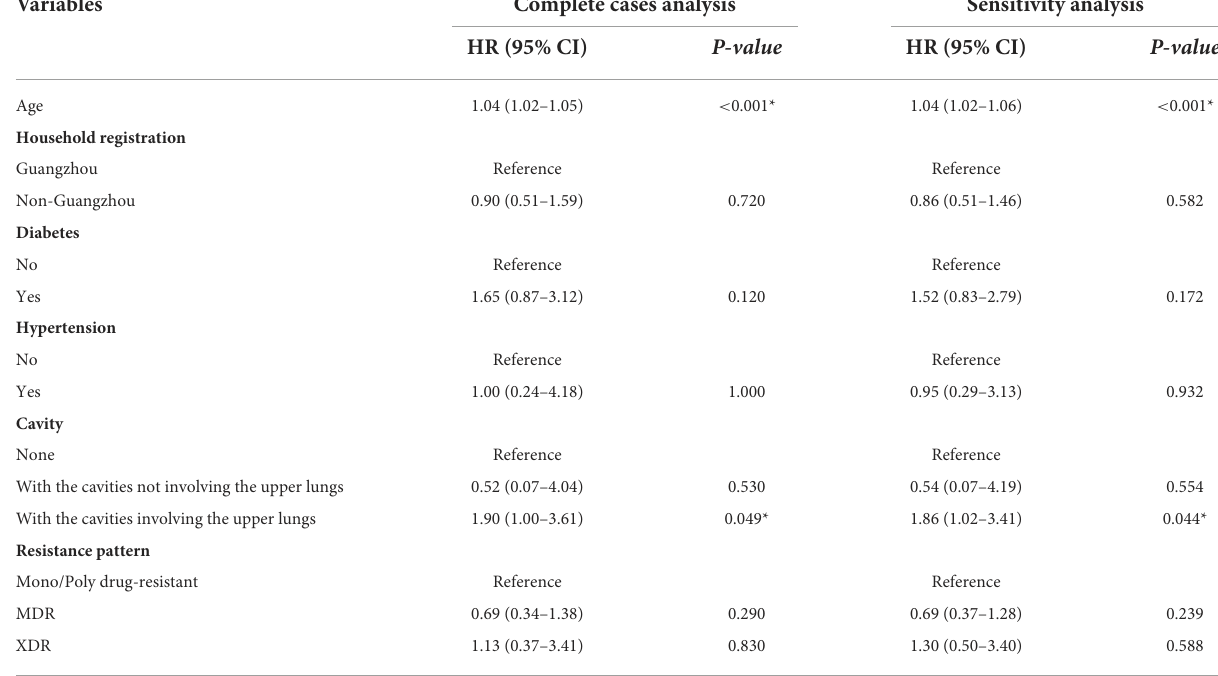
TABLE 3 Factors associated with poor treatment outcomes (i.e., death or failure) in patients with drug-resistant tuberculosis in Guangzhou, China, from 2016 to 2020 in complete case analysis and sensitivity analysis after multiple